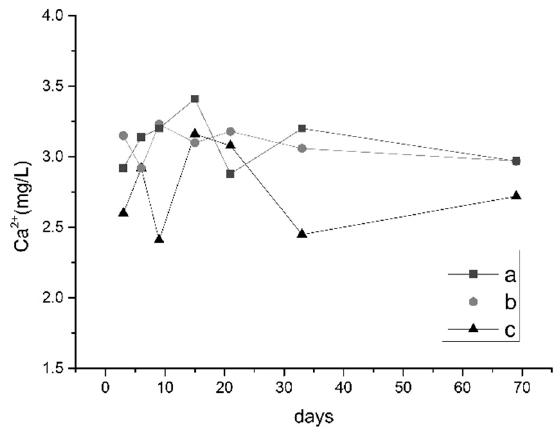
Figure 7. Ca 2+ concentration curve of sample liquids (a, b, and c, respectively, represent the Ca 2+ content in the liquids with oil shale heated to 300 °C, oil shale heated to 500 °C, and unheated oil shale). Acid roots were measured in the three samples and Figure 8 shows their content curve over